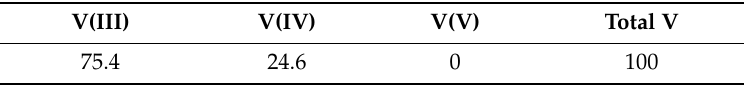
Figure 1. ( a ) XRD pattern of the black shale; ( b ) SEM-EDS patterns of the muscovite. Table 2. Vanadium valence distribution in the black shale